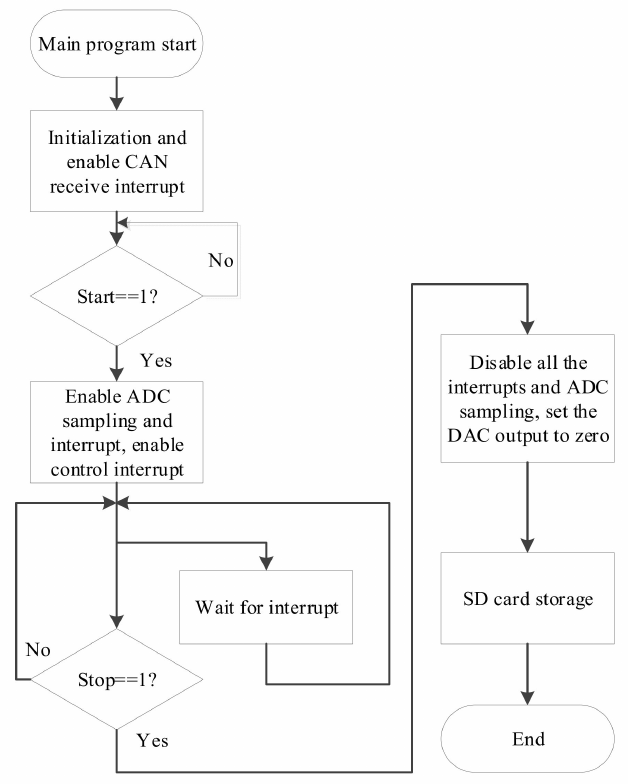
Figure 6. The flow chart of the main